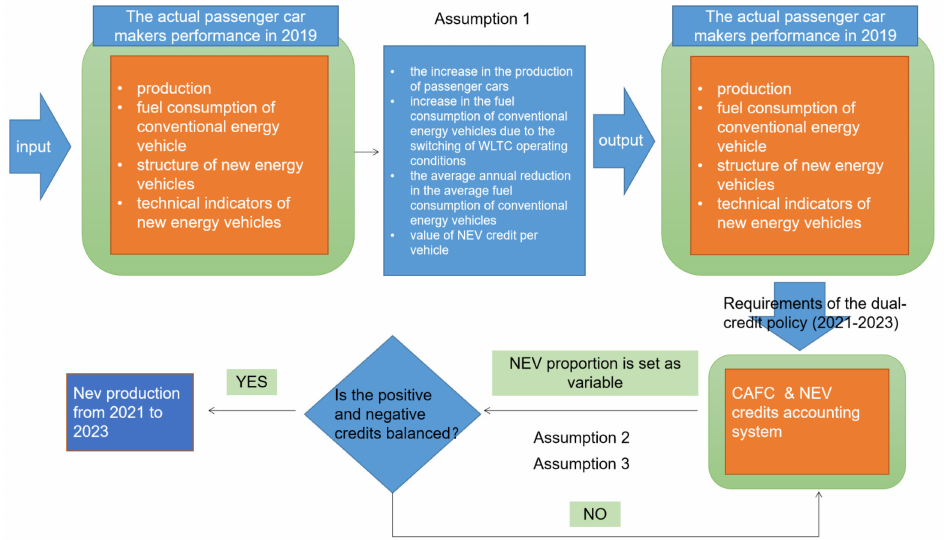
Figure 1. Overall assessment framework of impact of the dual-credit